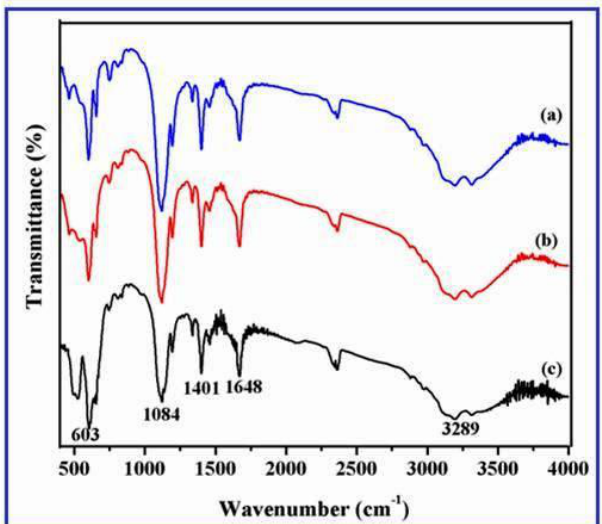
Figure 5. FT-IR spectra of γ-Fe 2 O 3 nanostructures synthesized using different % (1%, 2% and 3%) of AV extract ( a ) nanoparticle aggregates ( b ) nanobelts and ( c ) nanodots, respectively.